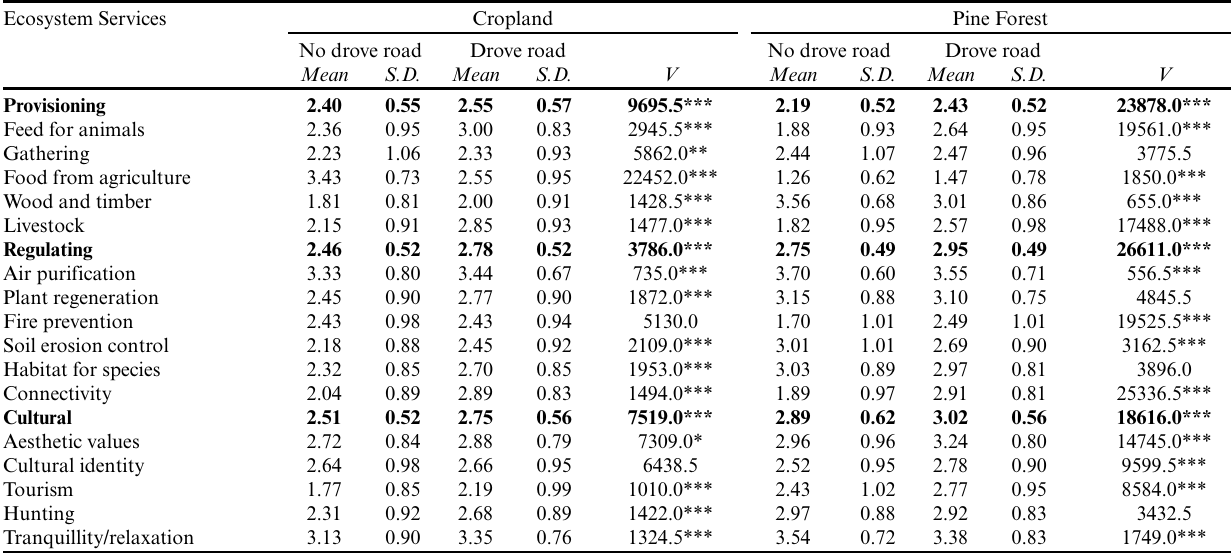
Table 1 . Comparison of the perceptions about ecosystem services in the two study landscapes (croplands and pine forests), with and without the drove road, using the paired Wilcoxon signed-rank test. Mean scores (and standard deviation) are also shown. Significant